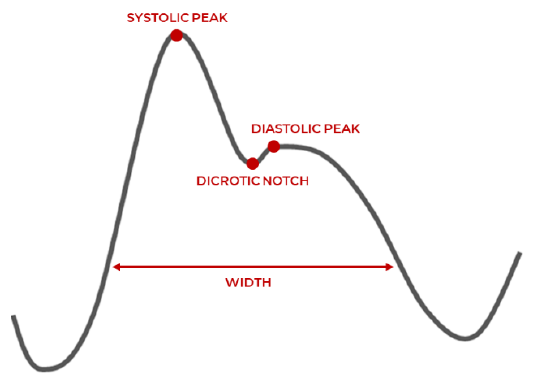
Figure 2. PPG waveform characteristics [3].